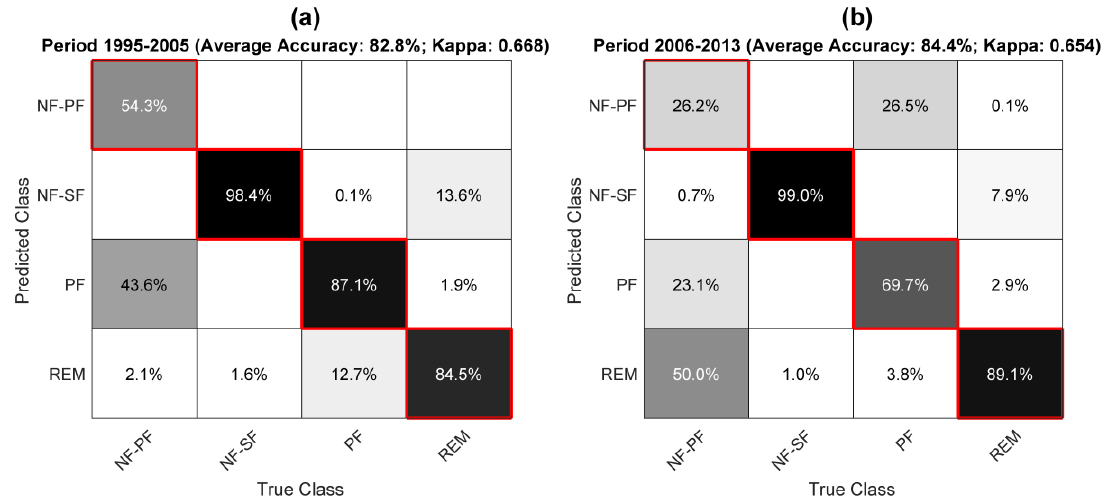
Figure 2. Confusion matrices obtained for forest transition maps produced for ( a ) period I (1995–2005) and ( b ) period II (2006–2013). The diagonal cells (highlighted in red) show the classification accuracy of each transition class, while the off-diagonal cells show the percentage of classification error between classes. Empty white cells refer to less than 0.01% misclassification. NF-PF = non-forest to planted forest; NF-SF = non-forest to secondary forest (successional); PF = conservation of planted forests; REM = conservation of forest remnants.